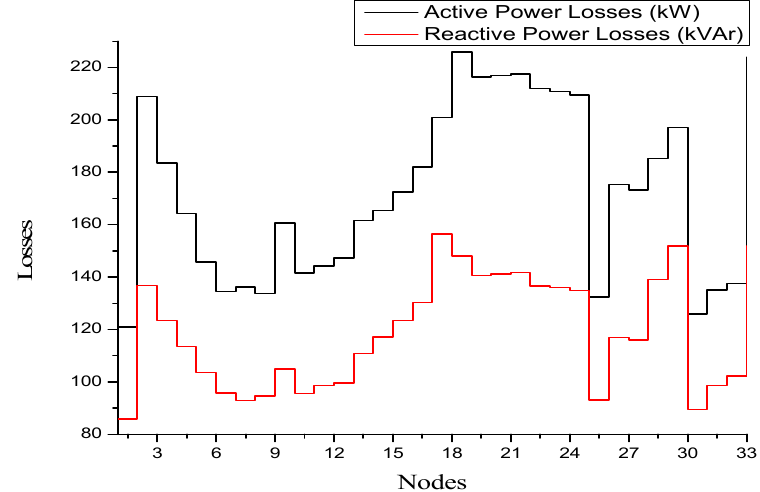
Figure 3. Active and reactive power losses at each node after integration of RES and EVCS.